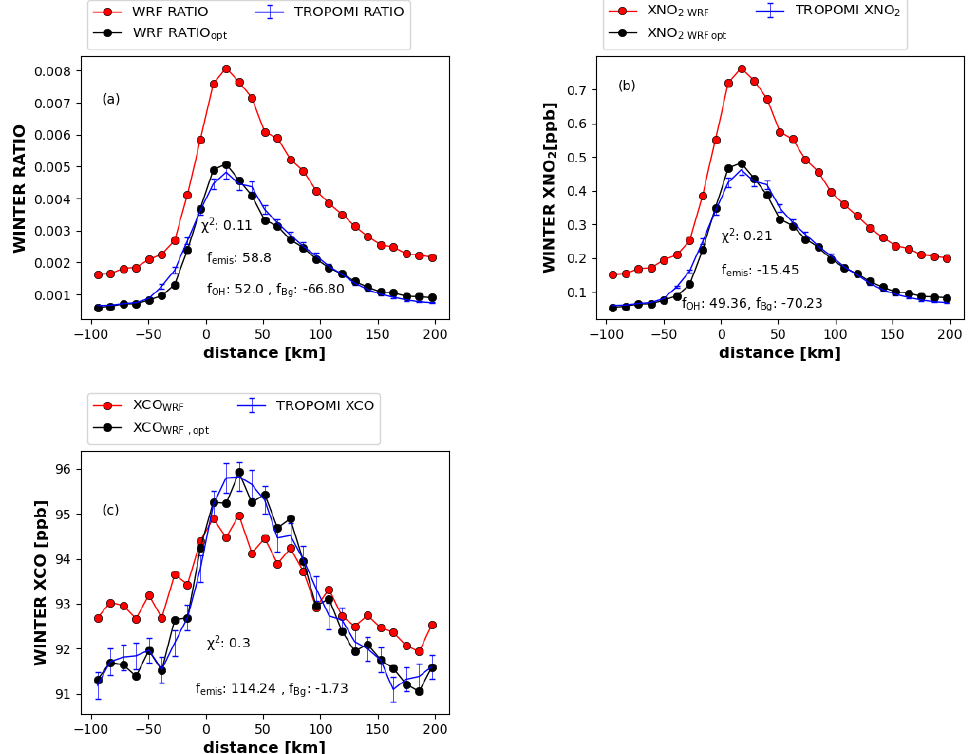
Figure 5. As Fig. 4, for winter (averaged over November 2018 to March